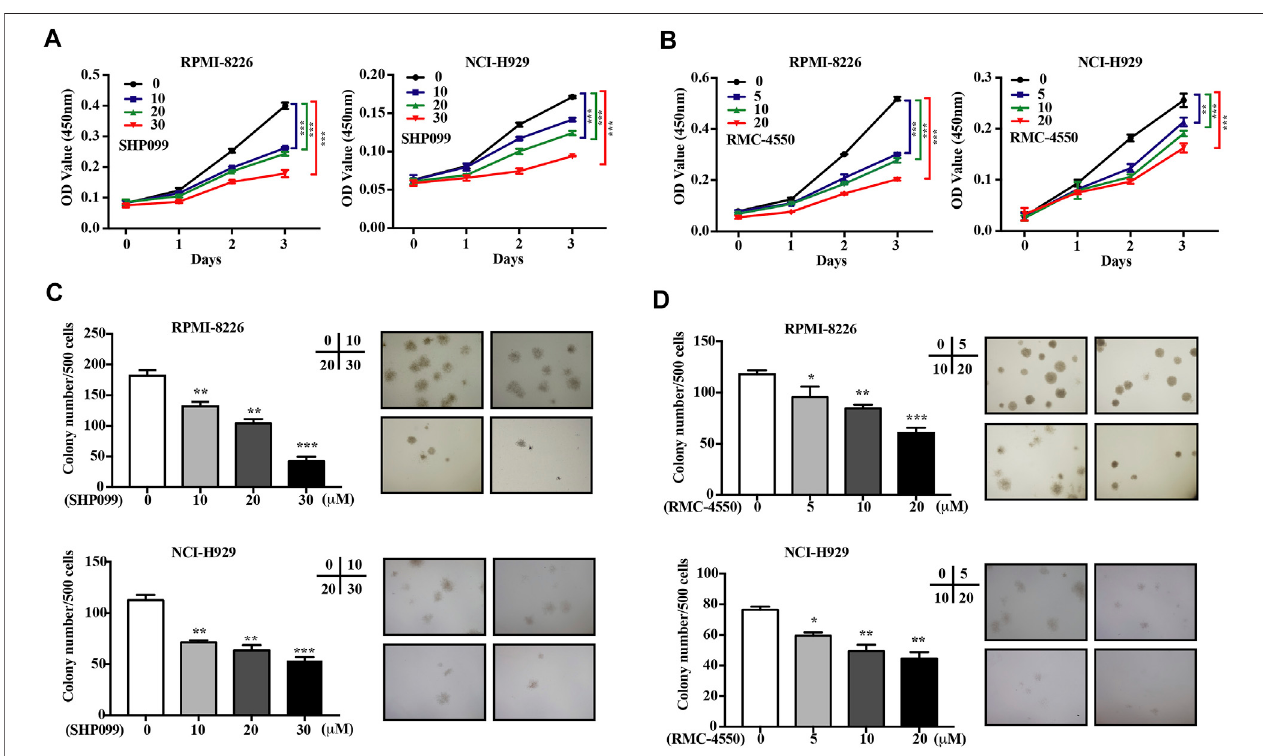
FIGURE1| SHP2inhibitorsinhibitthecellviabilityandcolonyformationabilityofMMcells invitro . (A,B) MMcelllines(RPMI-8226andNCI-H929)weretreatedwith SHP099orRMC-4550atdifferentconcentrationsfor24,48,and72 h,followedbymeasurementofthecellviabilityusingCCK-8assay. (C,D) Effectofdifferentdosesof SHP099andRMC-4550onthecolonyformationabilityinMM celllineswasshown,andrepresentativeimagesfromthesurvivingcolonieswerecapturedbymicroscopy (4×). The data are representative of the means ± SD from three independent experiments. * p < 0.05, ** p < 0.01, and *** p < 0.001 vs.